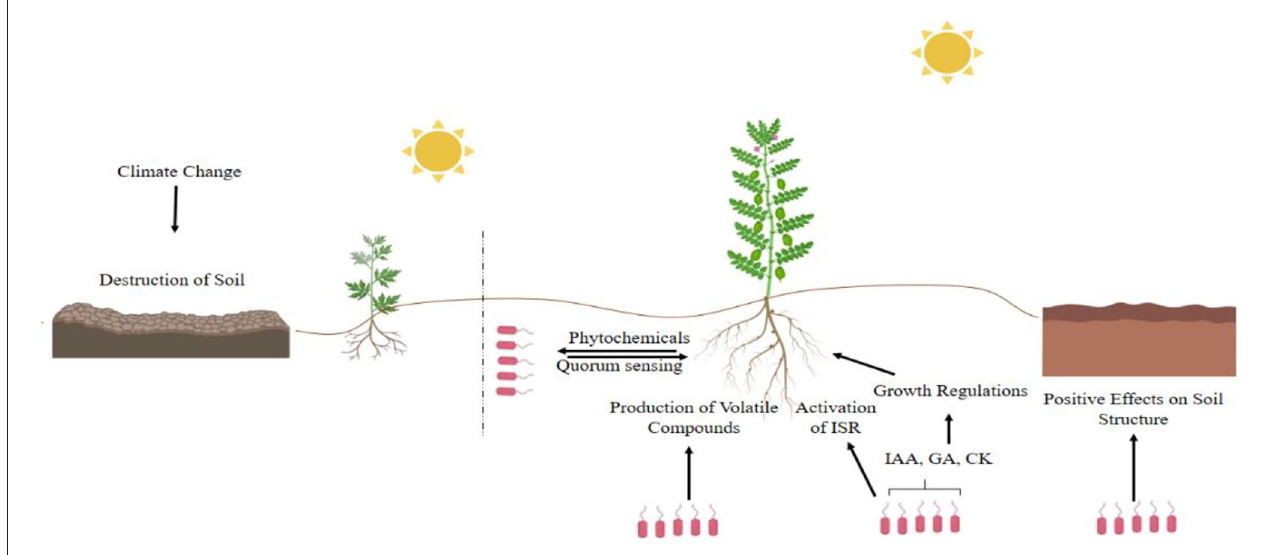
FIGURE 4 | Signaling and communication between host plants and rhizosphere bacteria. This chemical communication results in the formation of improved plant growth and stress resistance and also improves the soil structure and porosity under saline